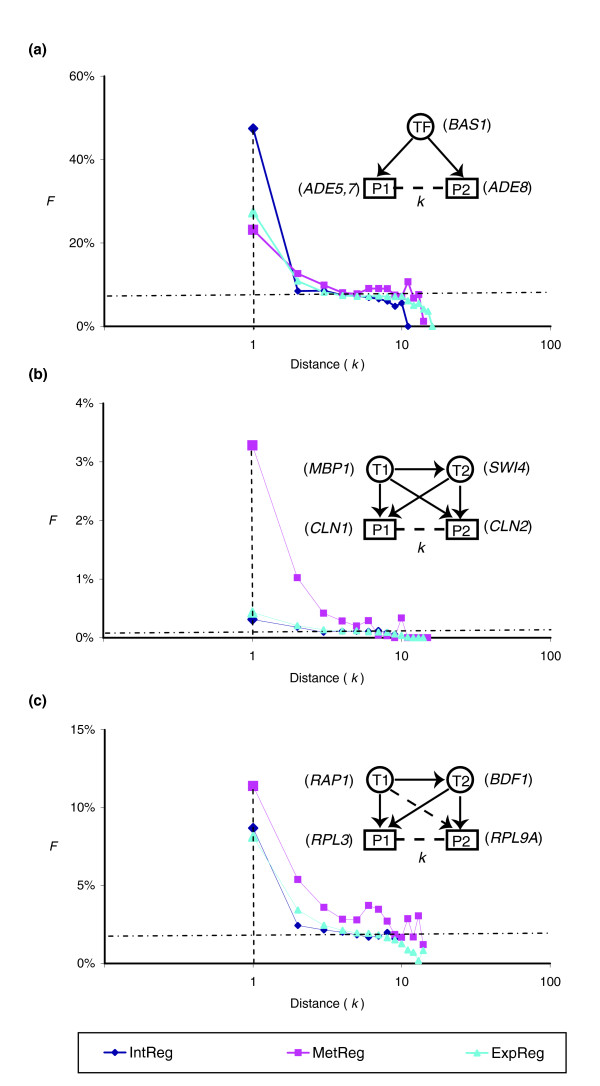
Fraction (F) of all P1-P2 pairs at distance k in a given combined network in a particular composite motif. Horizontal dashed lines indicate the random expectation. Vertical dashed lines indicate connected pairs in combined networks. (a) Triangles. The schematic shows that a triangle consists of three proteins: the common regulator TF regulates both P1 and P2. In all schematics, circles represent TFs, and rectangles represent non-TF genes. For example, ADE5, 7 and ADE8 are two subsequent enzymes in the purine biosynthesis pathway [7]. They are co-regulated by BAS1 [51]. (b) Trusses. The schematic shows that a truss consists of four proteins: T1 regulates T2, P1 and P2; T2 regulates P1 and P2. For example, Cln1p and Cln2p are two subunits of the CDC28-associated complex [4]. They are co-regulated by Mbp1p and Swi4p [52]. Mbp1p also regulates SWI4 [8,53]. (c) Semi-trusses. A semi-truss is an incomplete truss: either T2 does not regulate P1, or T1 does not regulate P2. For example, RPL3 and RPL9A, components of the ribosome large subunit, are co-expressed [6]. They are co-regulated by Bdf1p [54]. Rap1p regulates both RPL3 and BDF1 [8,55]. We also examined the occurrence of triangles and trusses between protein pairs connected in more than one network, termed highly combined networks. We only considered semi-trusses to get better statistics, since the number of full trusses in highly combined networks is too small to be used. In all highly combined networks, triangles and semi-trusses are enriched between protein pairs connected in more than one network (Figure 8 in Additional data file 1). Met, the metabolic network; Int, the interaction network; Exp, the co-expression network; and Reg, the regulatory network.